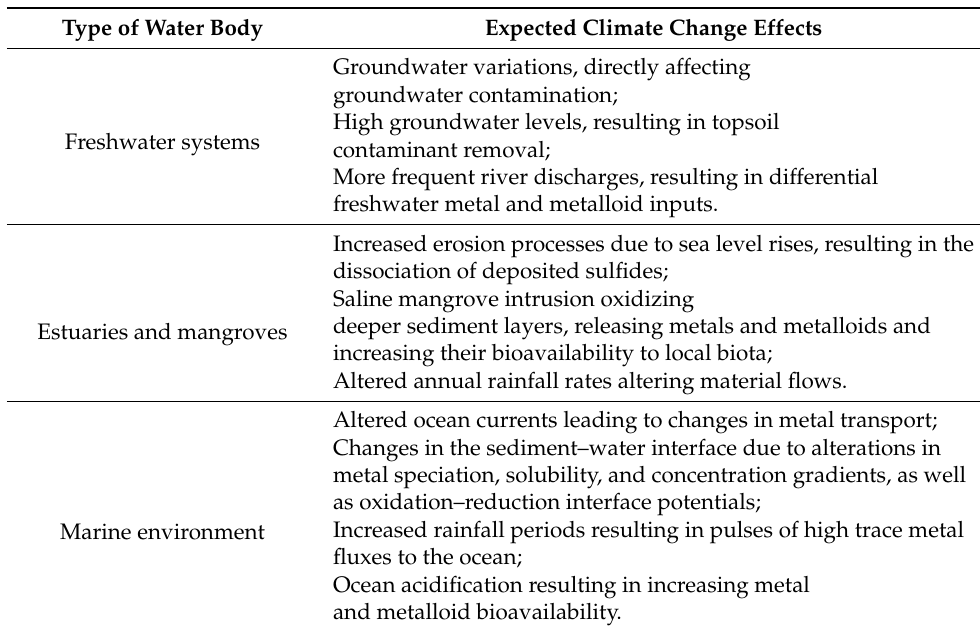
Table 1. Summary of expected climate change effects per type of water